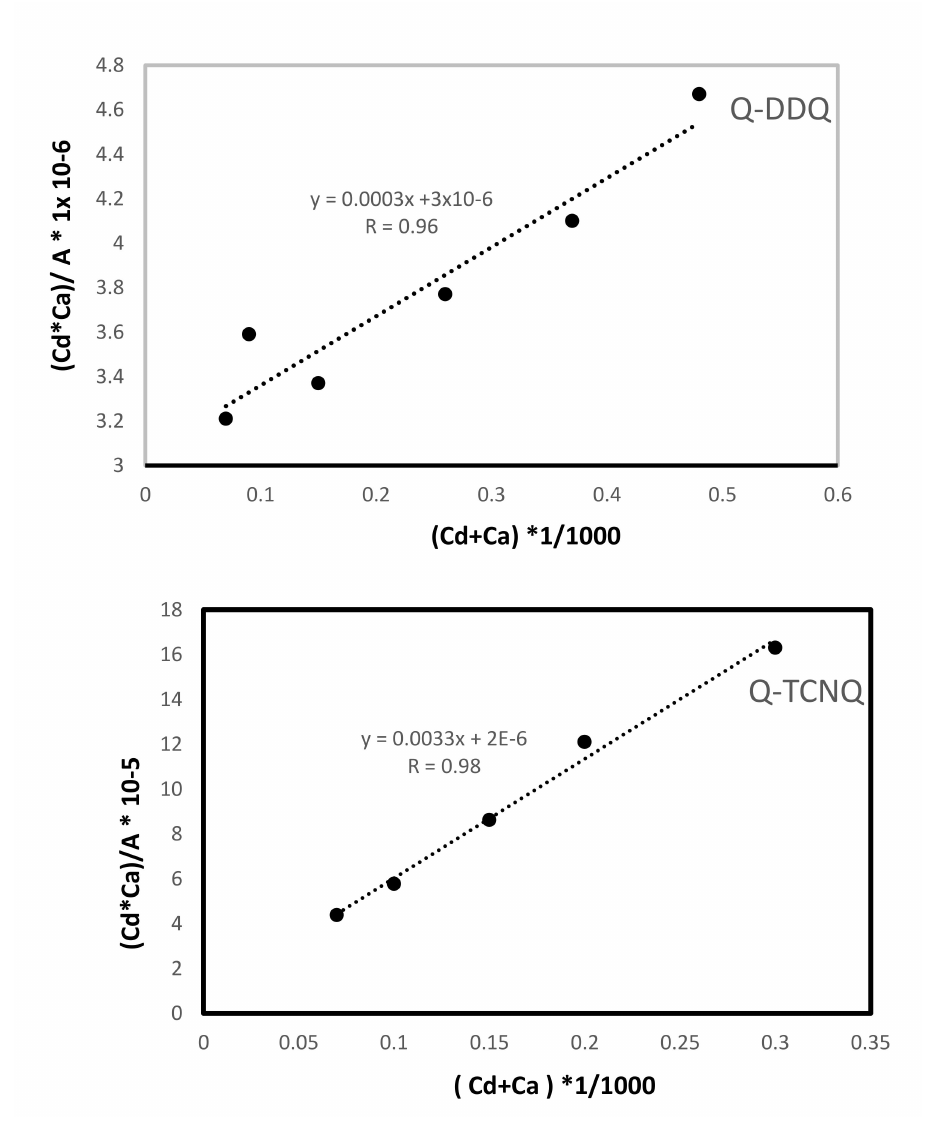
Figure 4. The 1:1 Benesi-Hildebrand Plot for Q-DDQ and Q-TCNQ CT complexes system. (Ca and Cd: initial concentration of acceptor, and donor, and A: